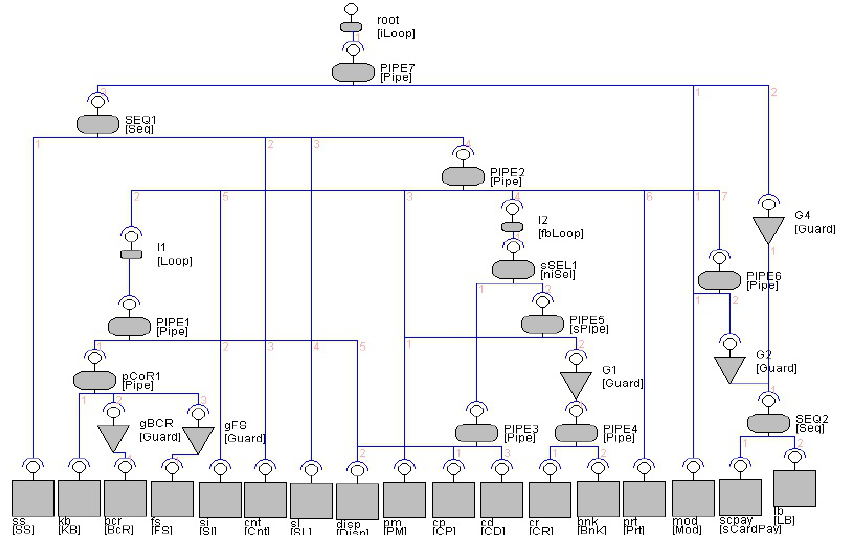
Figure 31. EX-MAN design of cash desk sub-system in Exogenous Composition Framework